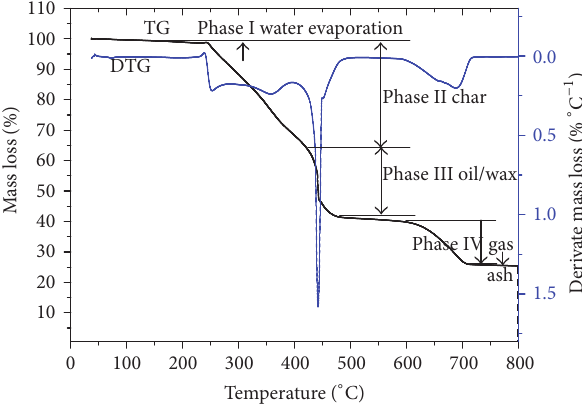
Figure 4: Decomposition curve for latex foam with heating rate of 10 ∘ Cmin −1 .